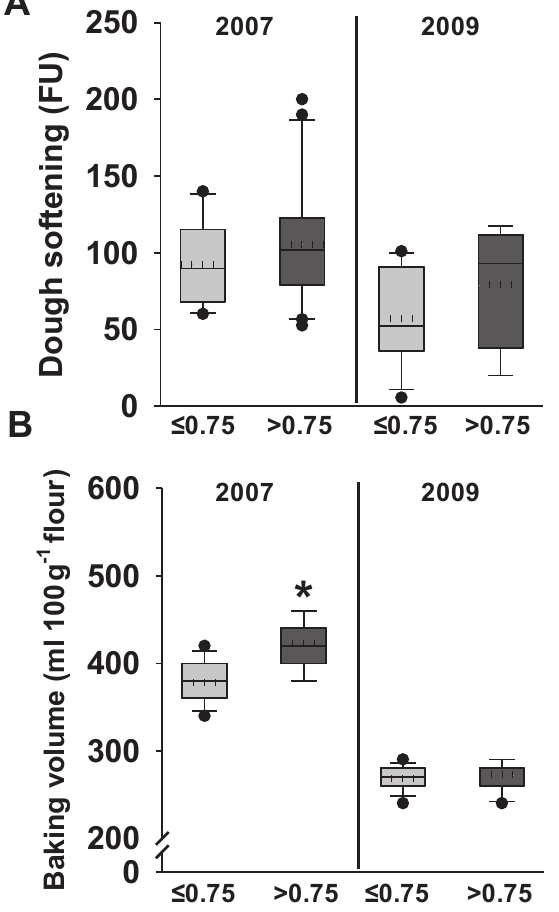
Fig. 6: Dough softening (A) and baking volume (B) of flour Type 550 sam- ples in 2007 and 2009 grouped into fulfilling (≤0.75) and exceeding (>0.75) EU maximum level of DON (mg kg -1 ) for flour. Signifi- cant difference between groups within year is indicated through * (p<0.001). Box plots show 25-75% percentile, median (solid line), and mean (dotted